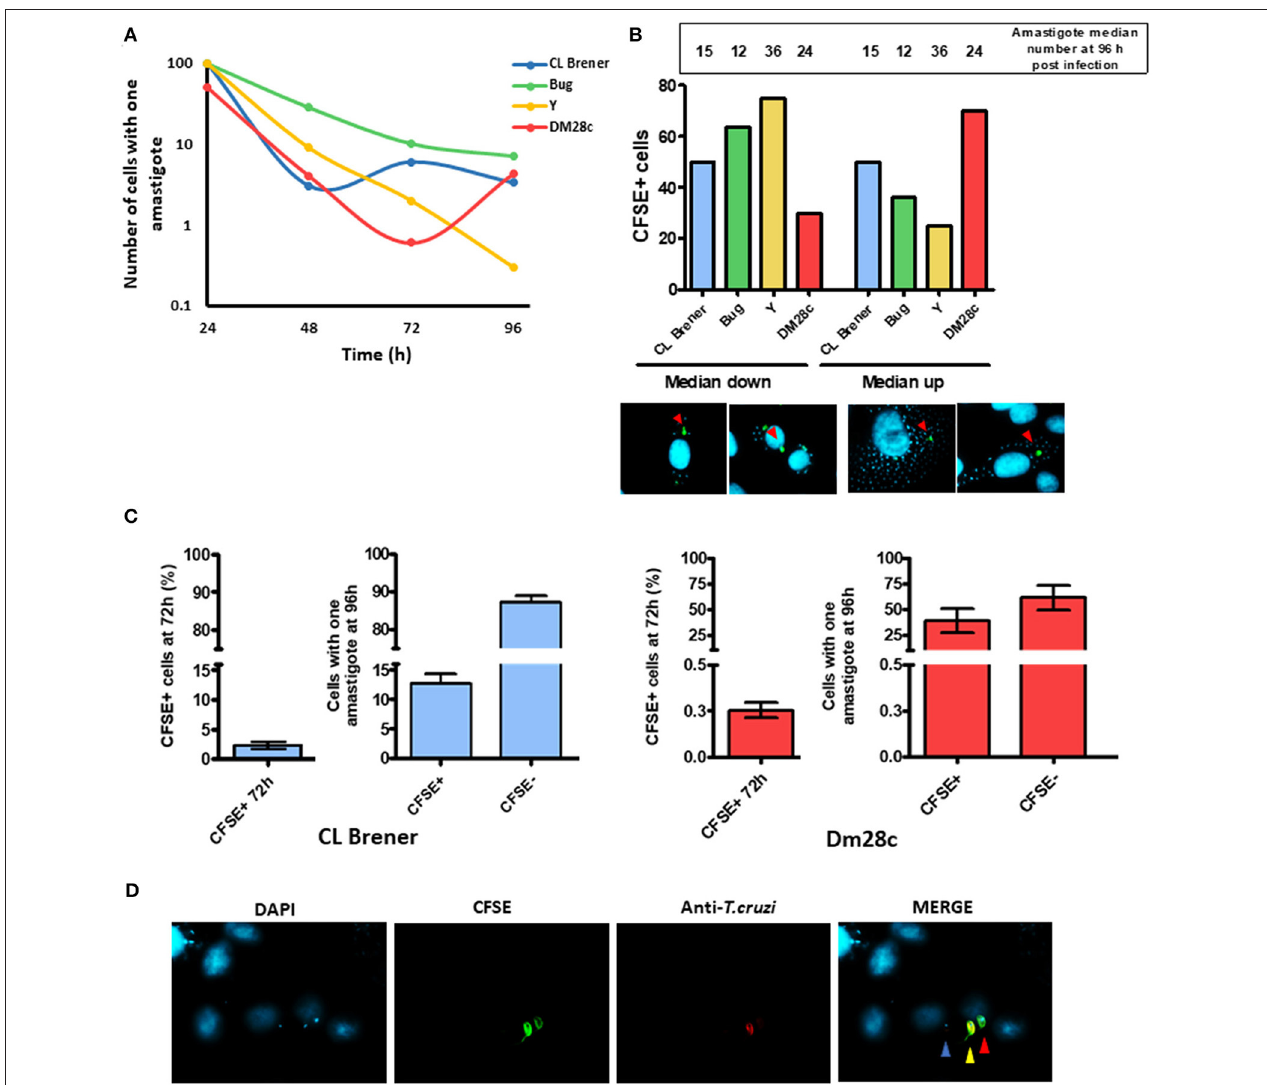
FIGURE 4 | Dormant reinfection characterization. (A) The graph shows the percentage of cells infected with a single amastigote along the infection. A total of 100 infected LLC-MK2 cells were analyzed at each time point and the infected cells with just one amastigote were counted. (B) The graph shows the percentage of cells containing CFSE-positive parasites according two groups of cells: one in which the number of intracellular parasites was higher than the median, and another one in which the number was lower than the median at 96h post-infection. Values indicated in the bar are the median for each strain at 96h post-infection. Below the graph, a representative figure depicting what was considered as cells with CFSE-positive parasites in a median down group or in median up group is shown. (C) The graph shows the percentage of cells infected with a single parasite from CL Brener or Dm28c strains at 96h that is either CFSE-positive or -negative. A hundred single-infected cells were analyzed per assay. For the sake of comparison, besides each graphic the percentage of total CFSE positive CL Brener or Dm28c parasites at 72h post-infection is shown. (D) Representative image of a cell infected with a single parasite (Dm28c strain), CFSE + (red arrow) or CFSE- parasite (blue arrow) at 96h post-infection. An external trypomastigote form is also shown (yellow